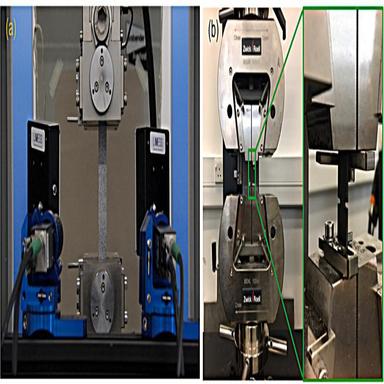
Test set-ups for: (a) quasi-static testing of ± 45◦ tensile specimens; (b) quasi-static testing of DENT specimens; and (c) intermediate strain rate testing of both specimen types and a zoom up image: in-plane shear (left) and DENT (right) specimens.